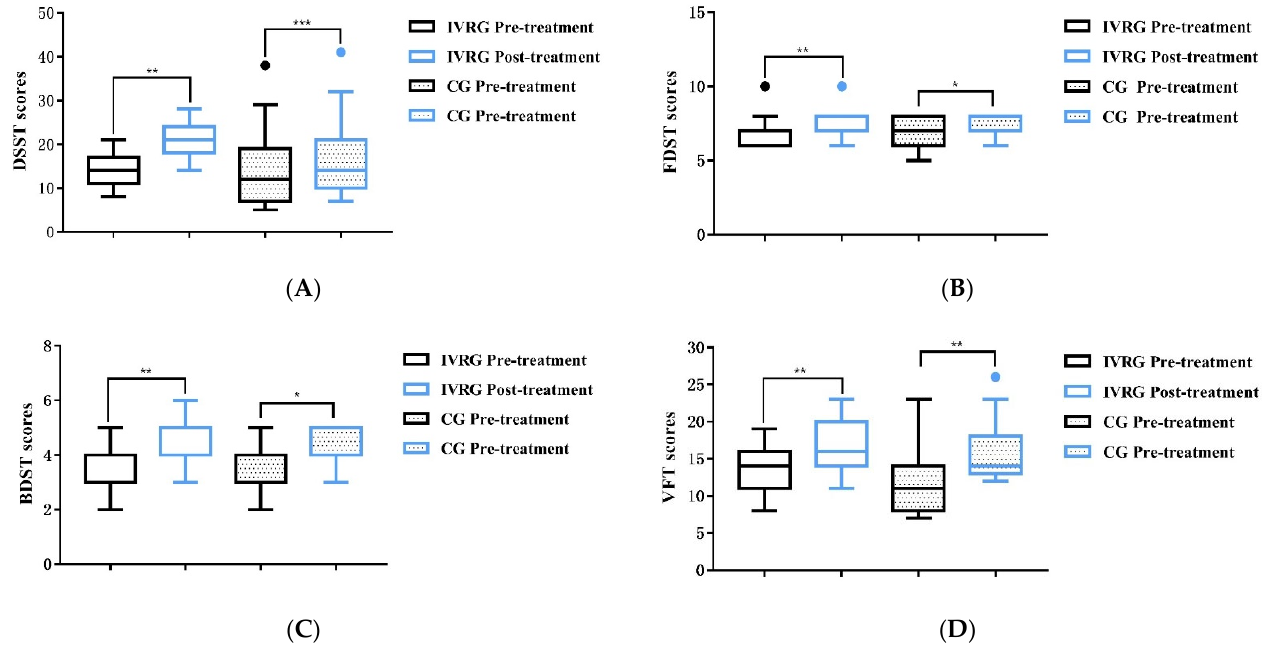
Figure 4. Boxplots comparing DSST( A ), FDST( B ), BDST( C ), and VFT( D ) between the IVRG and CG before and after treatment. Significant differences were observed in intragroup. *, p < 0.05; **, p < 0.01; ***, p < 0.001. Abbreviation: DSST: digit symbol substitution test; FDST: forward digit span test; BDST: backward digit span test; VFT: verbal fluency test; IVRG, immersive virtual reality group; CG, control group.